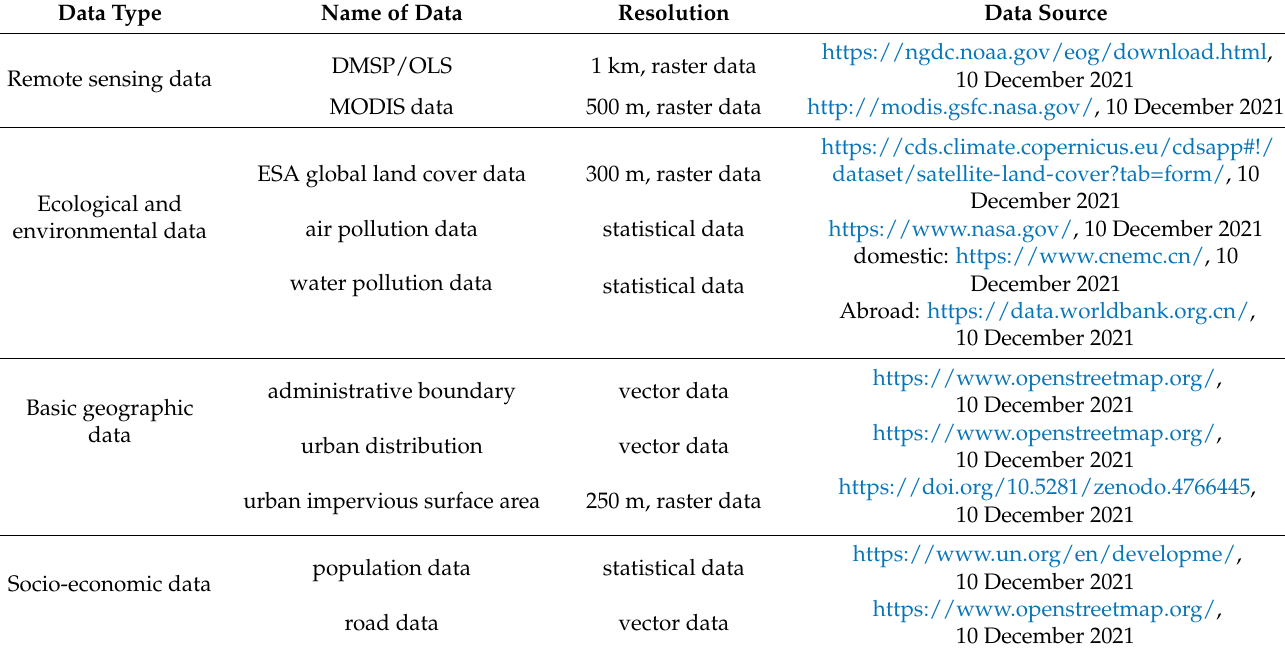
Table 2. Detail of the data used in this